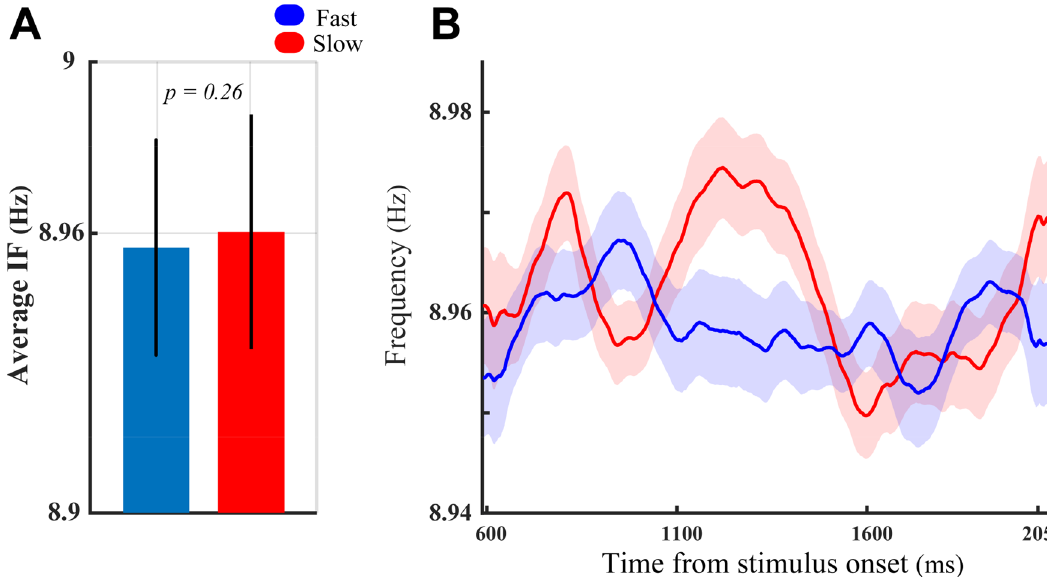
Figure 7. Functional significance of the theta–alpha frequency modulation at the target-out condition. The detailed explanation of ( A , B ) is the same as the panels shown in Fig. 5. ( A , B ), respectively, except the significance levels in ( A ) ( p > 0.25, two-sided sign-test) and ( B ) ( p > 0.05, two-sided Wilcoxon rank-sum test with FDR correction for multiple comparisons).